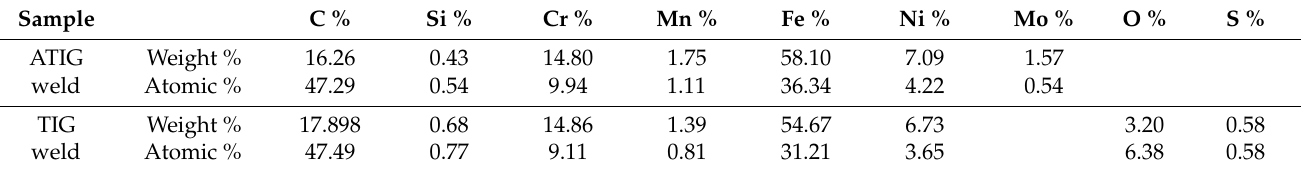
Table 14. Elements present in fracture face of ATIG welded zone and TIG welded zone.